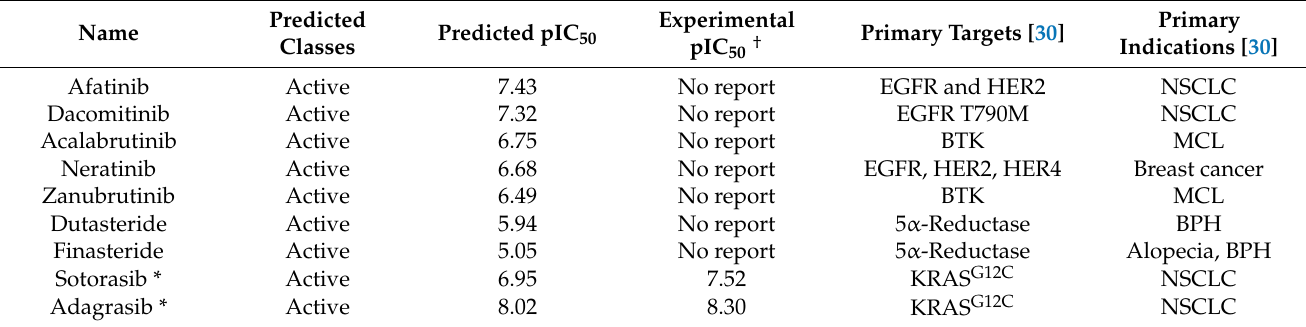
Table 2. Predicted FDA approved drugs against KRAS G12C protein.